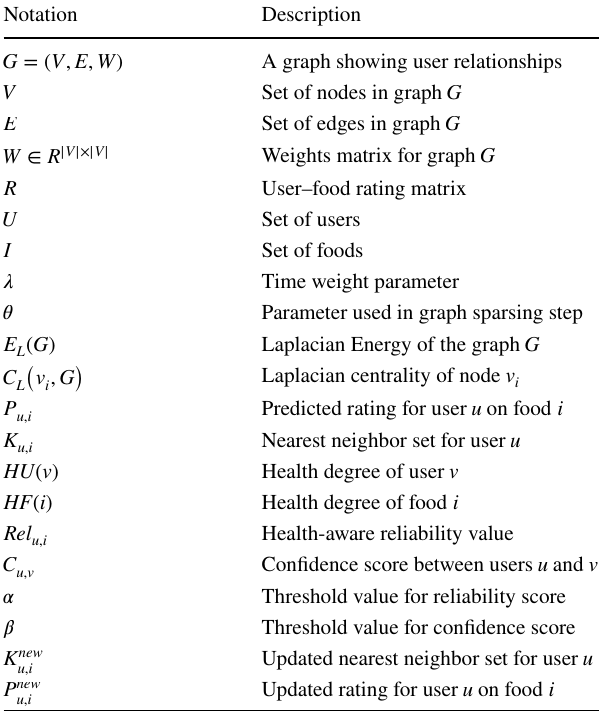
Table 2 The notations used in this work and their brief descriptions